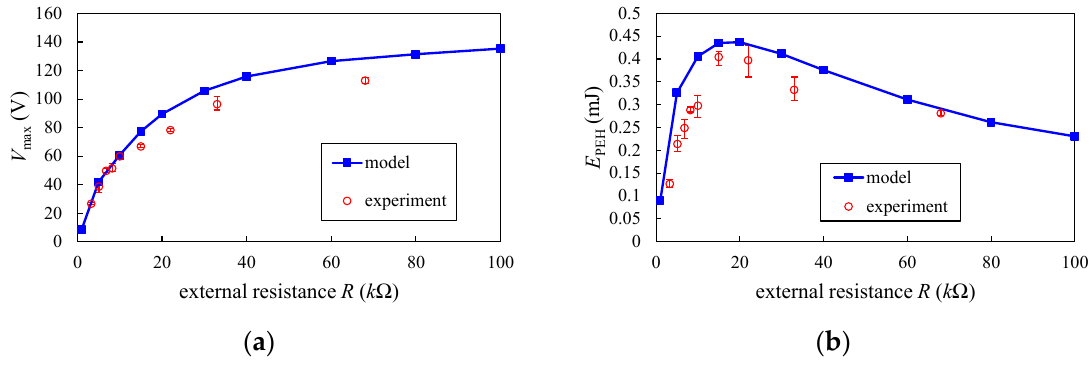
Figure 12. ( a ) The maximum output voltage of the PEH for various external resistance R ; ( b ) The energy harvested by the PEH for various external resistance R .